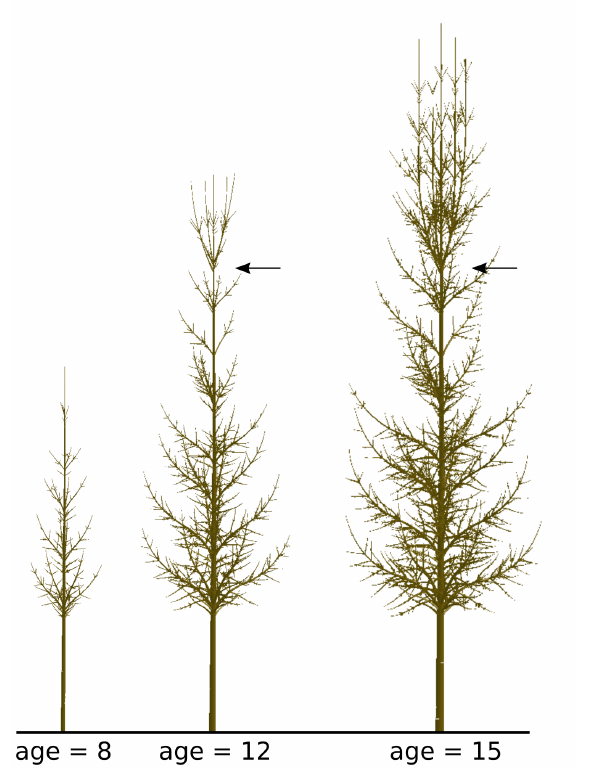
Figure 5. A tree simulated with the AmapSim model at 8, 12, and 15 years of age. The arrows indicate the location of the reiteration that occurs at age